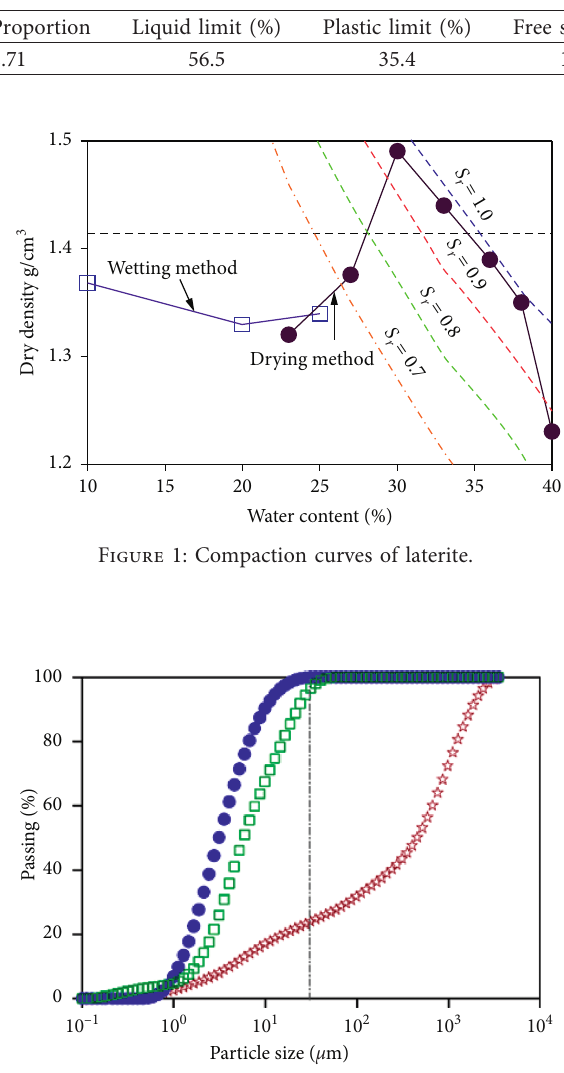
Table 2: Basic properties of laterite.